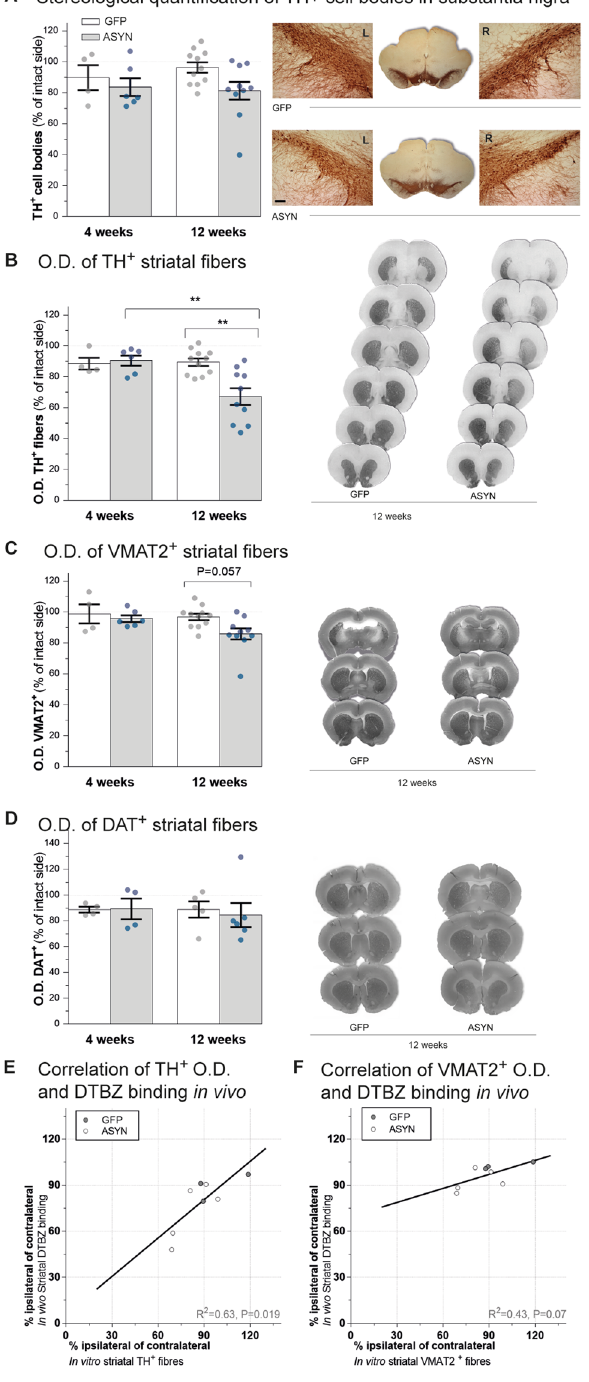
Figure 6. TH and VMAT2 histology. Stereological quantification of TH + cell bodies in SN in animals overexpressing GFP or ASYN revealed no significant cell loss in any groups ( A ) and no differences were found between both sides of SN in GFP (top right in A ) or ASYN animals (bottom right in A ) (Two way ANOVA, rAAV effect F(1,27) = 3.32 P = 0.079). Striatal dopaminergic innervation was also assessed ( B – D ). Bar graphs show semi-quantitative optical density (O.D.) analysis of TH + ( B ), VMAT2 + ( C ) or DAT ( D ) immunostaining in striatum per group and time. A significant reduction of TH + terminals was found in response to ASYN overexpression at 12 weeks (left B ). Representative TH immunostained sections from ASYN animals show a more severe loss of TH immunoreactivity in dorsal and caudal areas of striatum than ventral areas (right B ) Two way ANOVA (Interaction time & rAAV F(1, 27) = 6.83 P = 0.01; time effect F(1,27) = 5.82 P = 0.02; rAAV effect F(1,27) = 4.75 P = 0.03), followed by Tukey’s multiple comparisons. VMAT2 staining of striatal sections ( C ) revealed a smaller reduction of VMAT2 + terminals in ASYN animals at 12 weeks (P = 0.057). Two way ANOVA (Interaction time & rAAV F(1, 27) = 1.23 P = 0.27; time effect F(1,27) = 2.80 P = 0.10; rAAV effect F(1,27) = 3.94 P = 0.057). ( D ) DAT immunostaining did not show any differences. Remarkably, the densitometry analysis